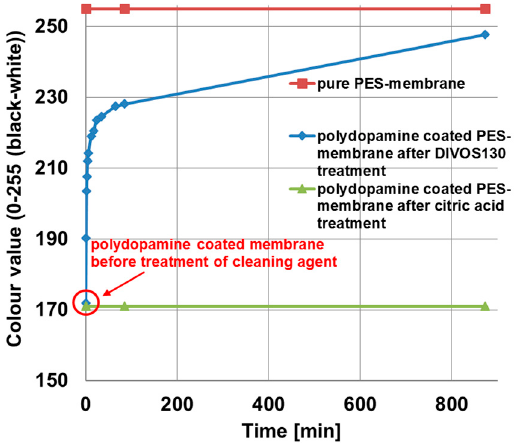
Figure 9. Stability study of PDA-coated PES membranes against chemical membrane cleaning agents: pure polyethersulfone membrane (red squares); after DIVOS130 treatment, containing mainly NaOH and EDTA (blue rhombs); and after two percent citric acid treatment (green tringles). The graph shows the change of the colour value with ongoing cleaning time, the value 0 means a completely black sample and 255 an uncoated polyethersulfone membrane.